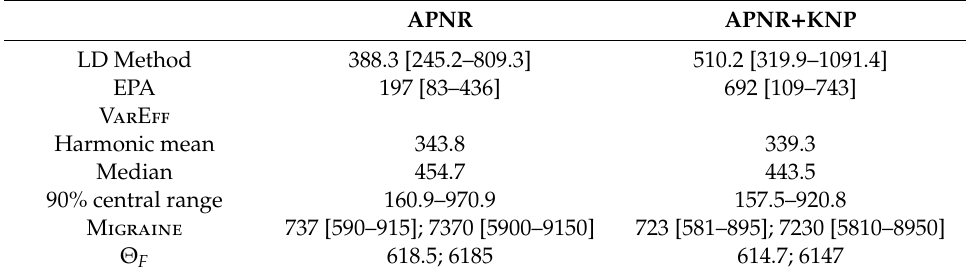
Table 4. Estimates of N e for the APNR and APNR + KNP obtained from the linkage disequilibrium (LD) method, the estimator by parentage assignments (EPA), V ar E ff with an average microsatellite mutation rate of 10 − 3 mutations per locus per gamete per generation (the tested rate that best fitted the data in the V ar E ff analyses), M igraine and the homozygosity-based estimator of Θ ( Θ F ; [112]). Values in parenthesis are 95% confidence intervals (CIs). For M igraine and Θ F , estimates are given assuming an average microsatellite mutation rate of 10 − 3 or 10 − 4 mutations per locus per gamete per generation,